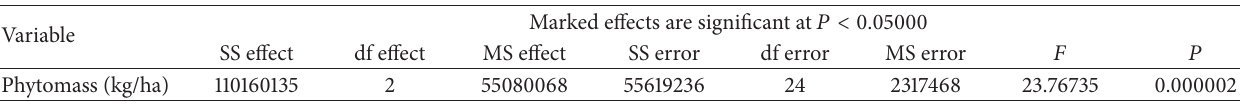
Table 2: Results of the one-way ANOVA statistical test indicating significant differences between the mean phytomass values of the three techniques.